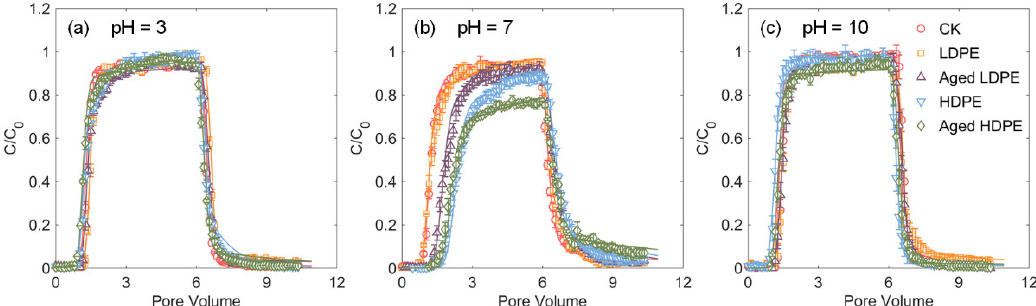
Figure 3. The breakthrough curves of tetracycline in pure quartz sand (CK) and quartz sand mixed with pristine and UV-weathered LDPE and pristine and UV-weathered HDPE at pH = 3 ( a ), pH = 7 ( b ) and pH = 10 ( c ), respectively.